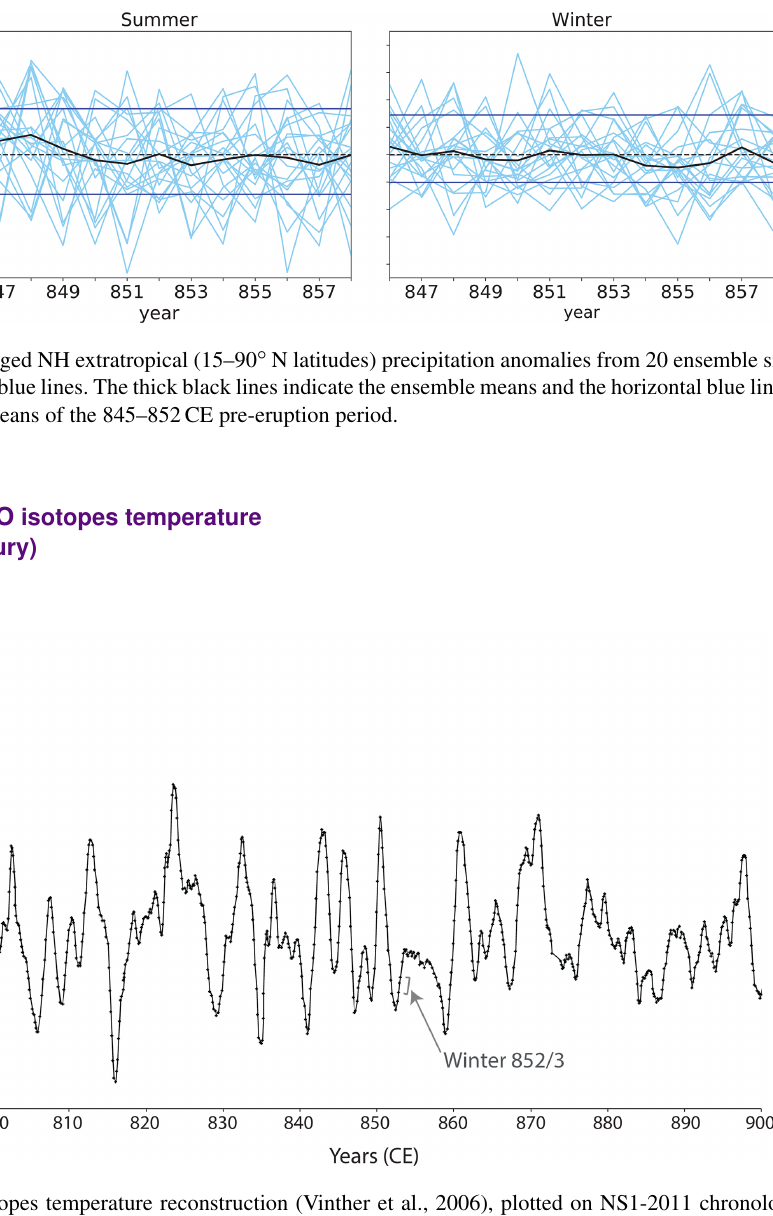
Figure I1. NGRIP1 δ 18 O isotopes temperature reconstruction (Vinther et al., 2006), plotted on NS1-2011 chronology (Sigl et al., 2015). Warmer (colder) temperatures are represented by higher (lower) δ 18 O values. The eruption age estimate for the 852/3CE Churchill eruption is